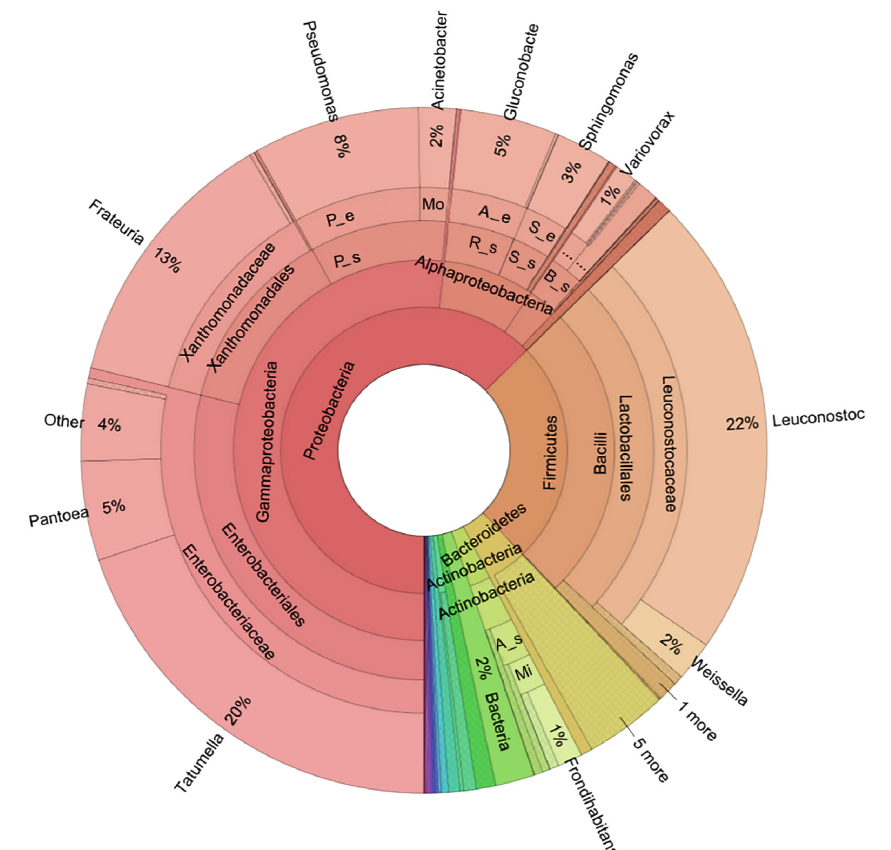
Figure 2. Prokaryotic microbial community distribution on M. alba carposphere. A_e – Acetobacteriaceae